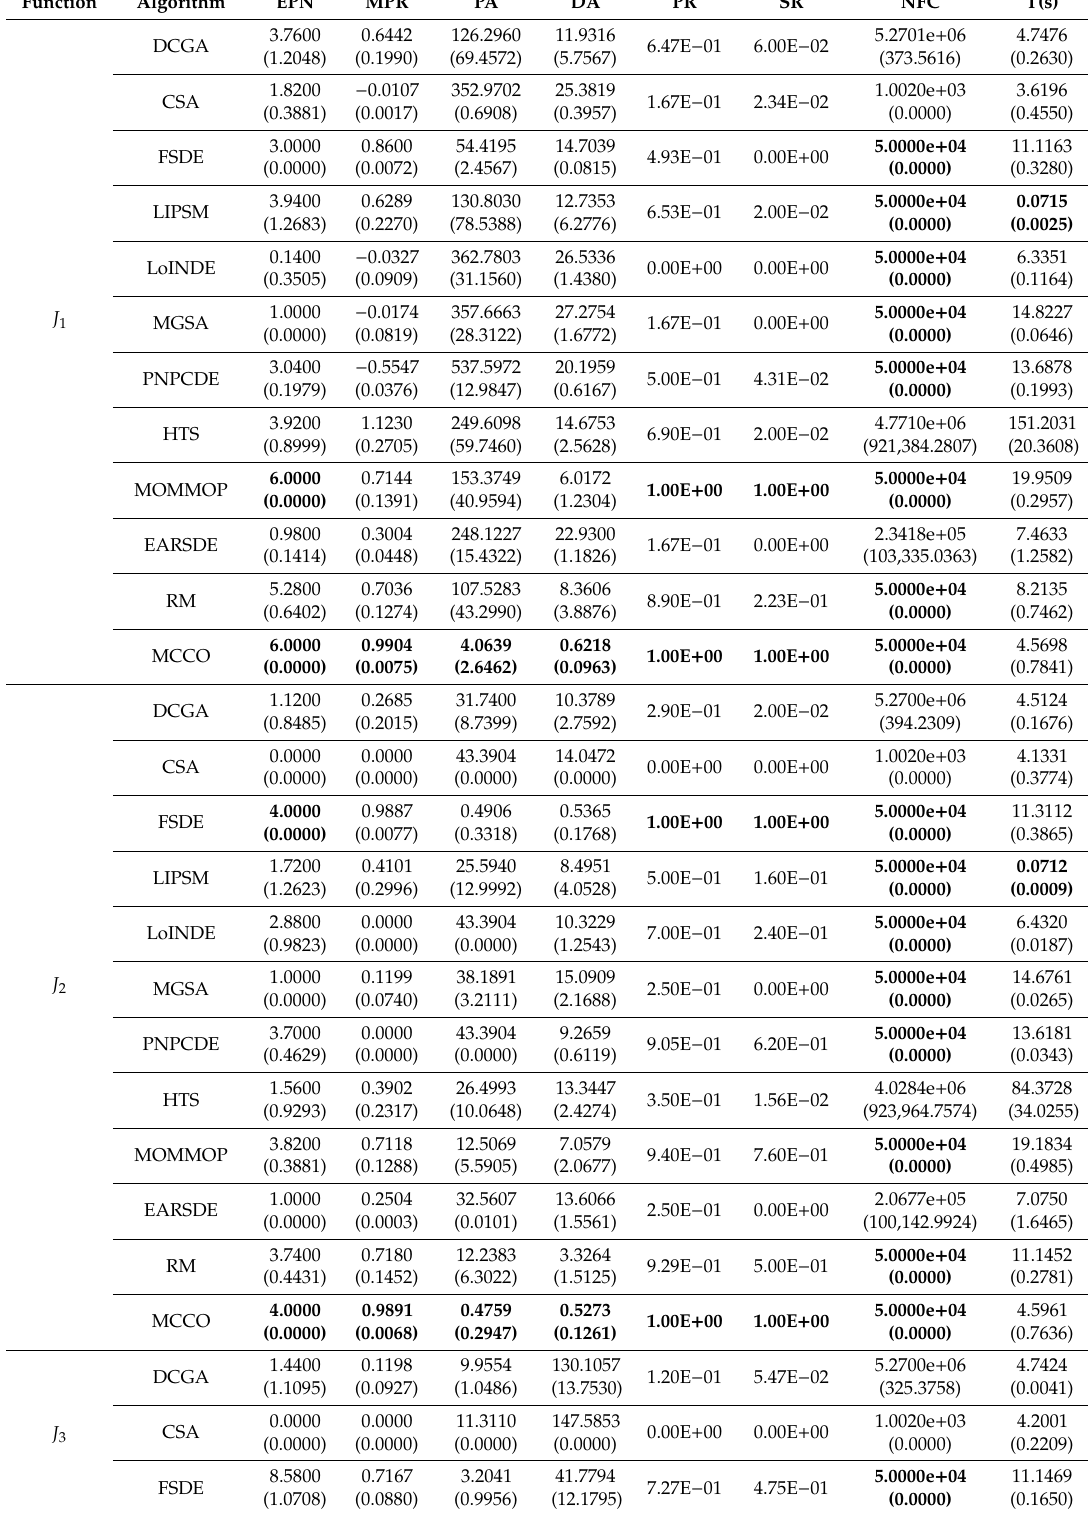
Table 3. Numerical results for J 1 – J 7 multimodal test